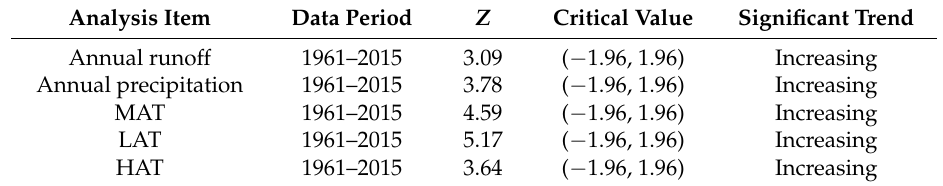
Table 1. Results of MK tests for annual runoff, annual precipitation and temperature (MAT, LAT and HAT).